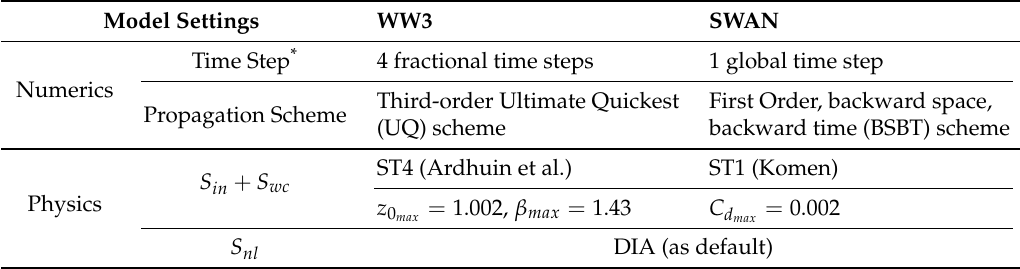
Table 1. Numerical and physical settings used in WW3 and